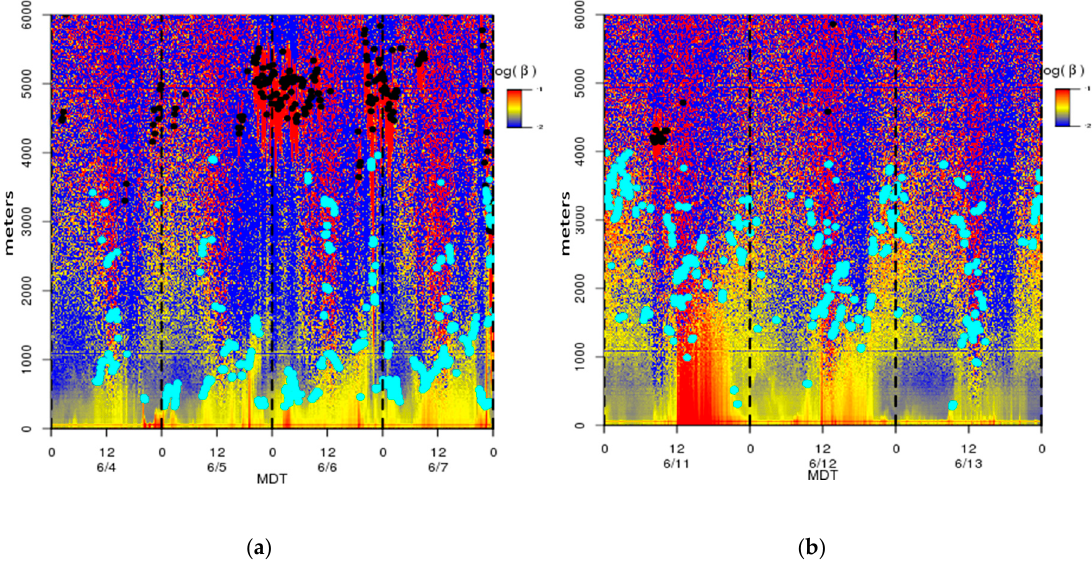
Figure 13. ( a ) Aerosol backscatter heatmap time series profile for the high ozone episode period. The black dots represent the cloud base detection, and the cyan dots are the aerosol mixing layer height estimated by BL-View; ( b ) for low ozone days. β represents the aerosol backscatter intensity.